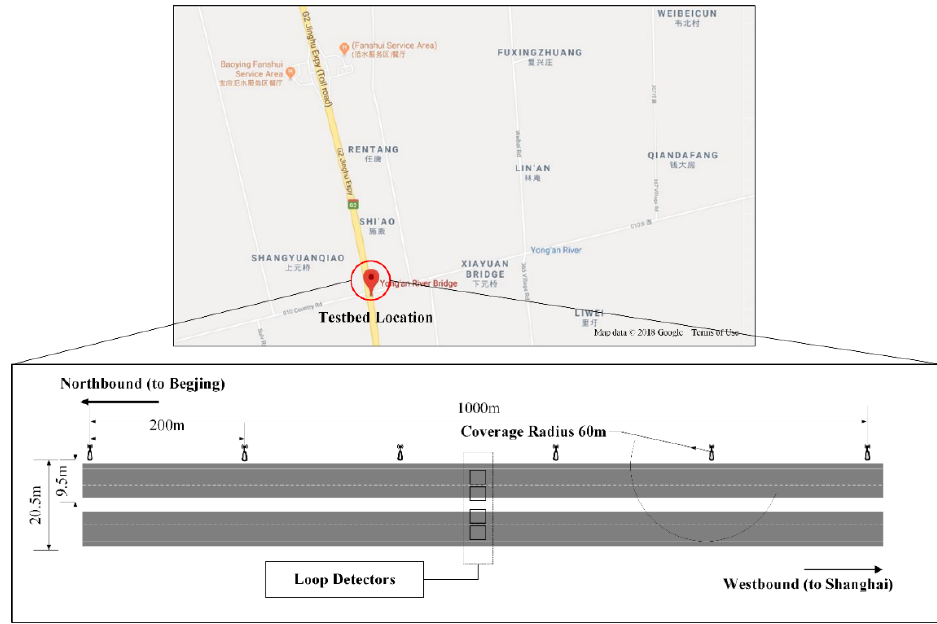
Figure 4. General view of the research corridor as well as the detailed layout and indications of the testbed ( Note: background map photo is from Google Maps ).